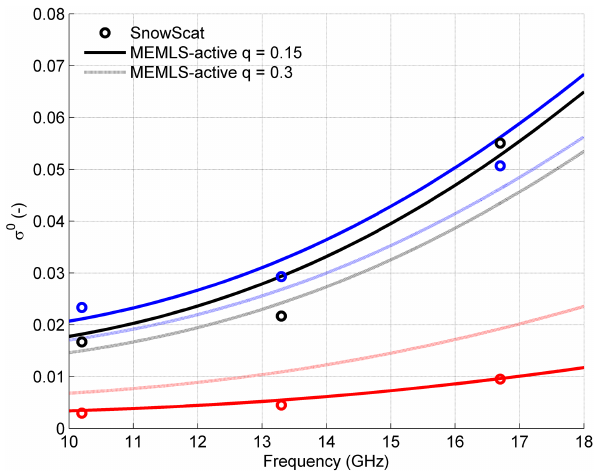
Figure 11. σ 0 at incidence angle 50 ◦ measured by SnowScat (cir- cles) and modeled by MEMLS3&a with CT input (lines) for differ- ent cross-polarization ratios q . Higher q ratios lead to lower σ 0 val- ues for co-polarization and higher σ 0 values for cross-polarization. Colors represent polarization, with vv – black, hh – blue and hv – red. Best fit parameters according to Fig.